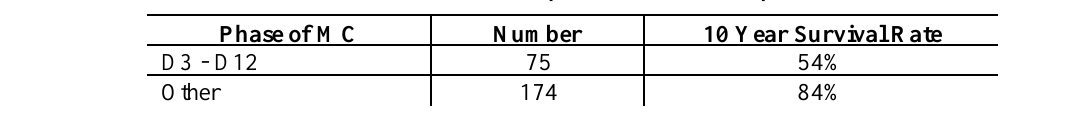
Table III : 10 YSR of women operated in different phases of MC.